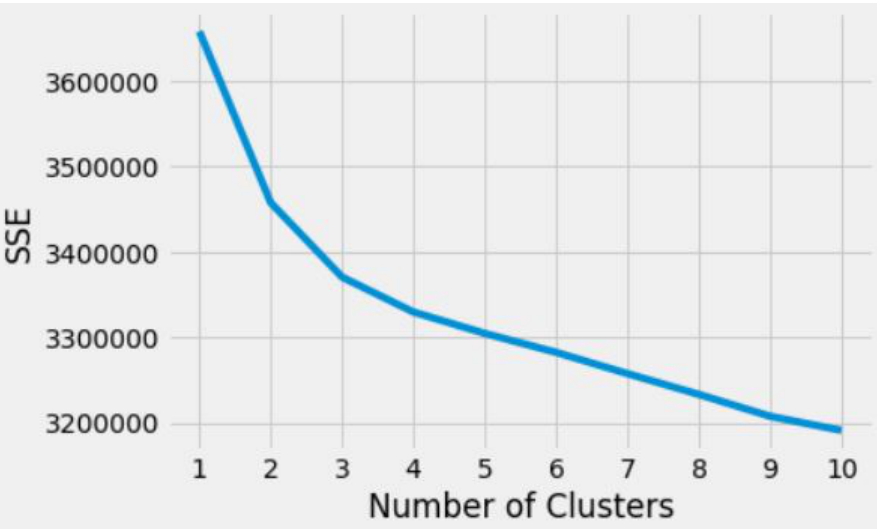
Figure 2. Optimal number of clusters displayed by the elbow method